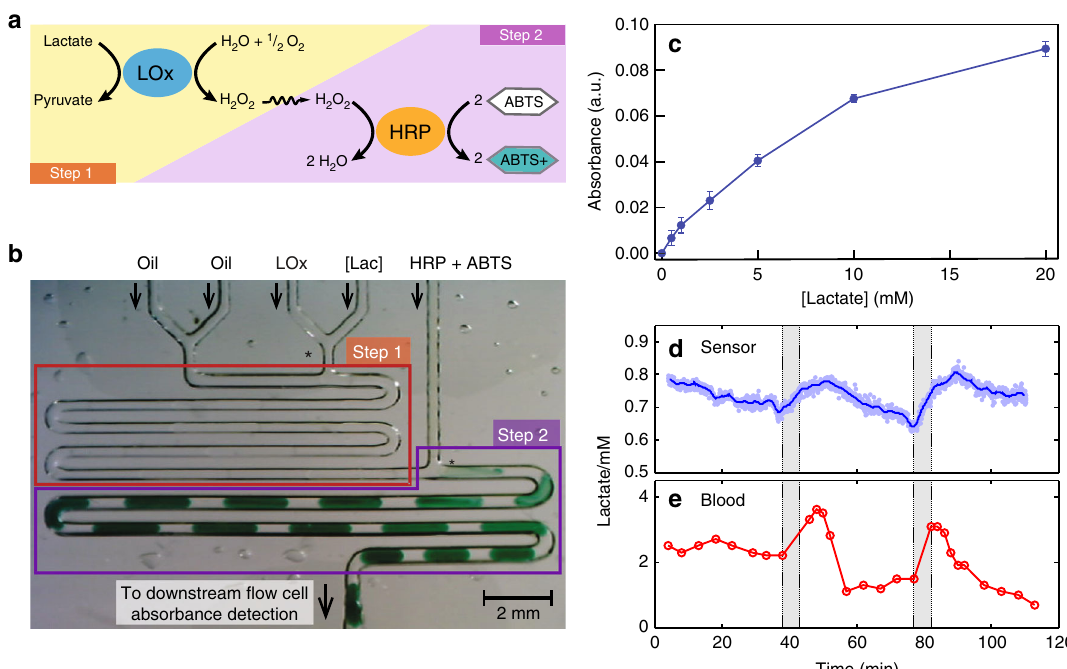
Fig. 5 Lactate assay, calibration, and in vivo testing. a Reaction scheme for the lactate assay. Step 1 — Lactate is broken down by lactate oxidase (GOx) to yield hydrogen peroxide (H 2 O 2 ) and pyruvate. Step 2 — The H 2 O 2 is then catalysed by horseradish peroxidase (HRP) to oxidise 2,2 ′ -azino-bis(3- ethylbenzothiazoline-6-sulfonic acid) (ABTS) to a blue-green coloured species (ABTS + ). b Image of the lactate assay being performed on-chip. The asterisks (*) denote T junctions. Transparent droplets containing lactate samples and LOx at a 1:1 ratio are generated at the T-junction in Step 1. They then travel through the serpentine channel with enough time for the LOx reaction to run to completion. Upon dosing with HRP/ABTS at the second T-junction in Step 2, an intense blue-green colour starts to develop. c The two-step lactate assay (blue circles) gives a monotonic increase to 20 mM, with a near linear response at lower concentrations. Error bars refer to the standard deviation from measurement of multiple droplets. d In vivo sensor measurement of dialysate lactate from subcutaneous interstitial fl uid. Each data point represents a measurement from a single droplet with the line indicating the running average. The shaded areas indicate periods of blood occlusion to the tissue. e Blood lactate during the same